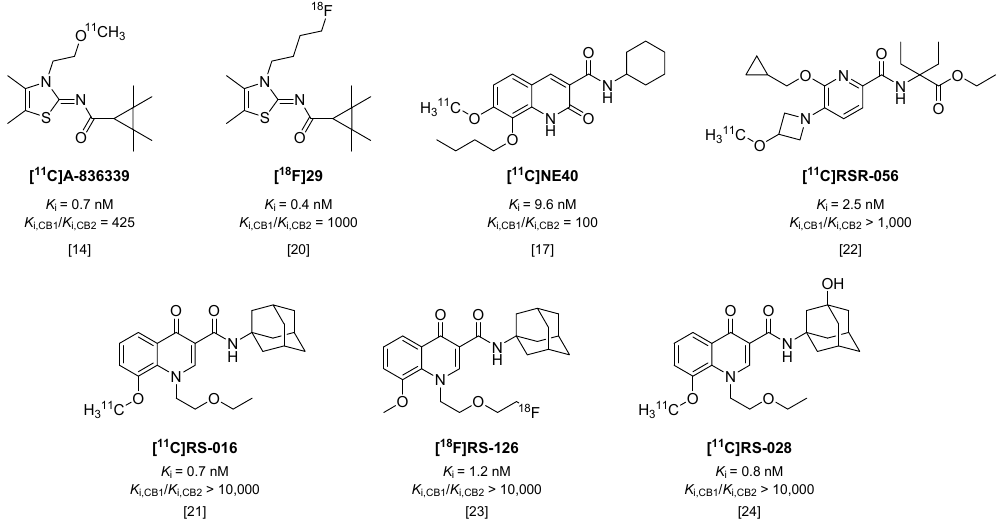
Figure 2. Radiotracers targeting the cannabinoid receptor type 2 (CB2).